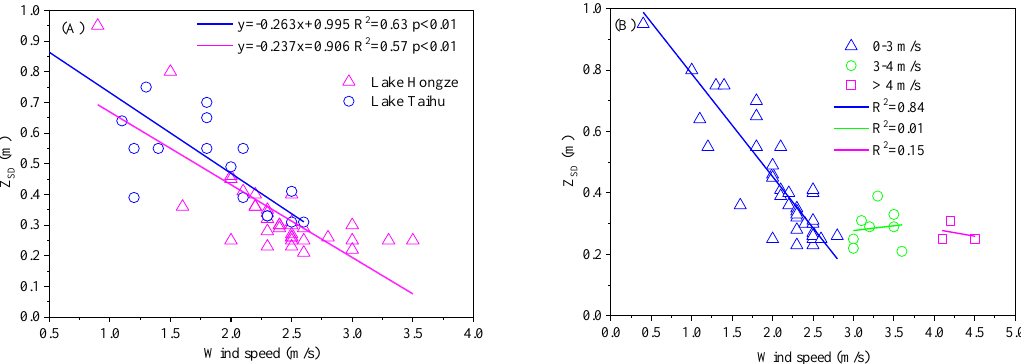
Figure 10. The relationship between Z SD and wind speed ( A ) and scatterplot of different levels of wind speed and Z SD ( B ).